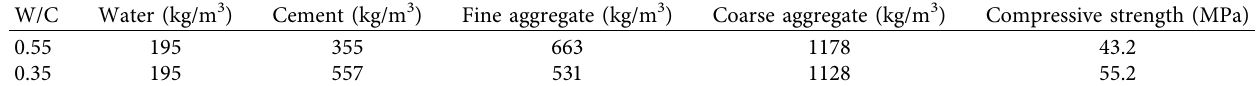
Table 1: Mix proportion of concrete and compressive